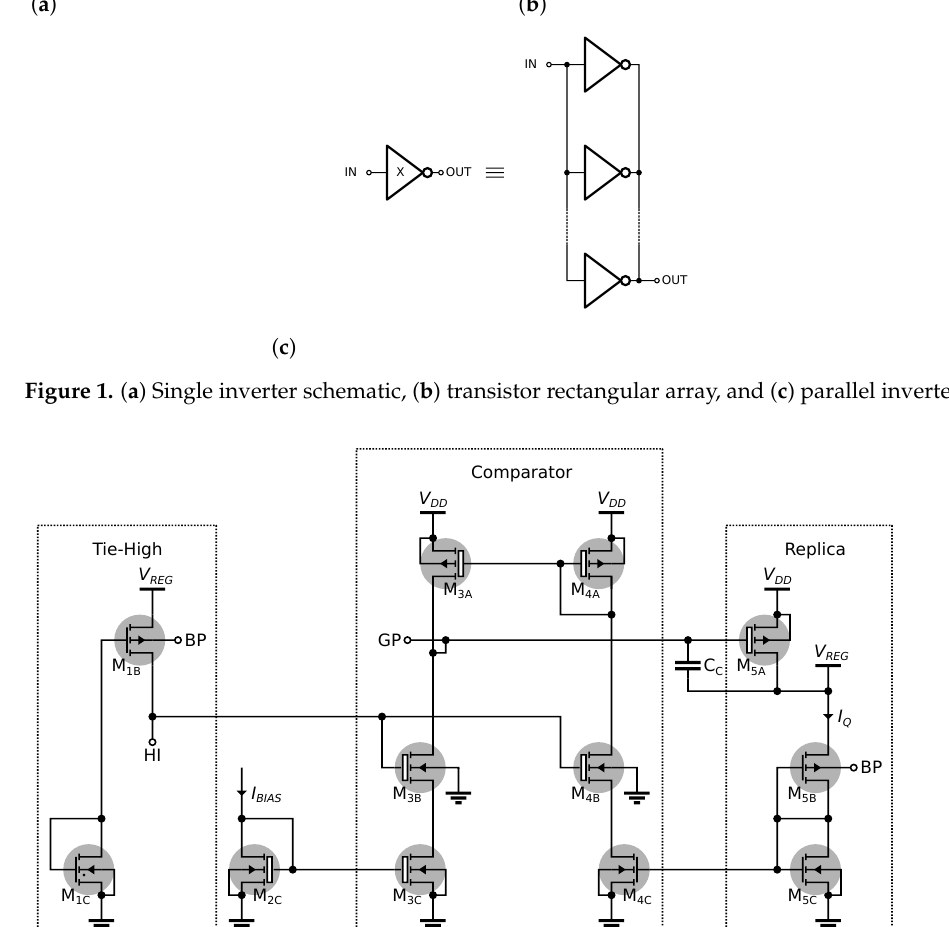
Figure 2. Quiescent current biasing